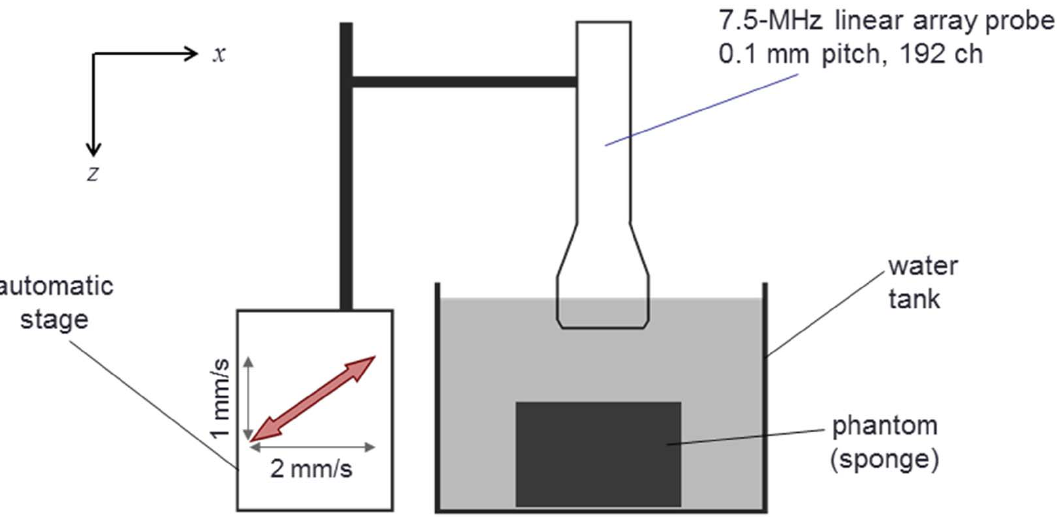
Figure 1. Ilustration of experimental